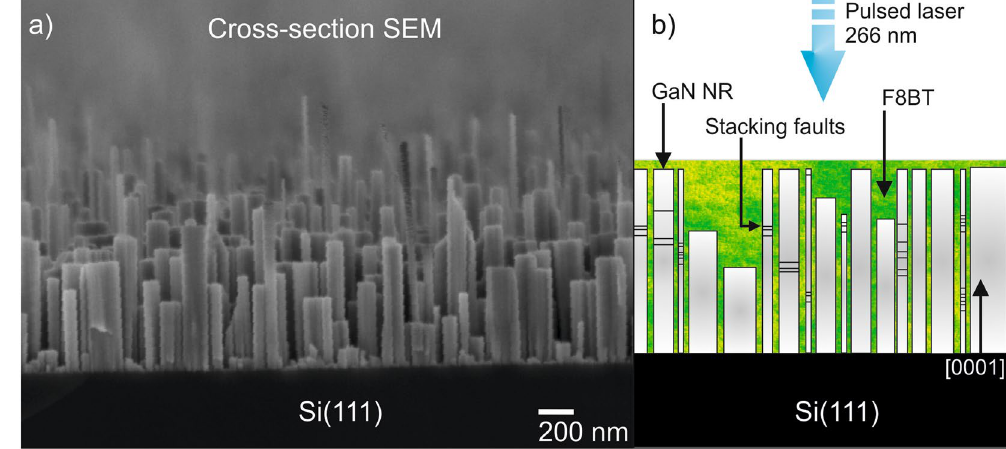
Figure 1. GaN NR sample ( a ) Cross section SEM and ( b ) illustration of cross-section hybrid sample with indicated stacking fault regions and incoming laser